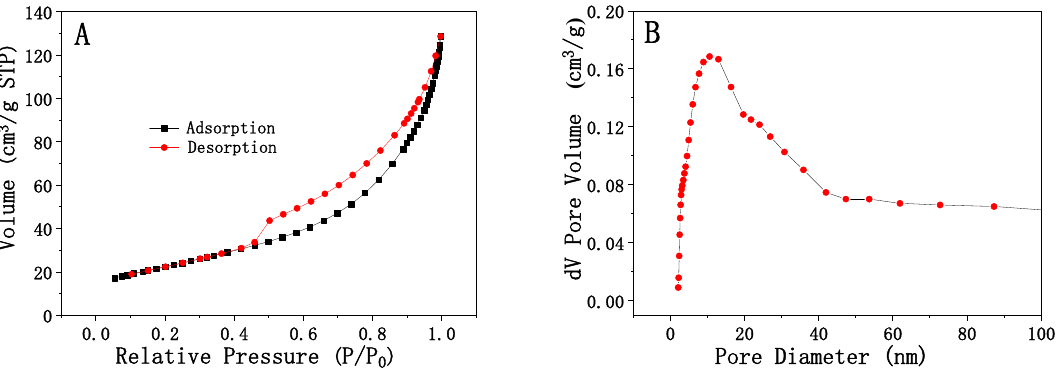
Figure 4. ( A ) N 2 sorption isotherms and ( B ) pore size distributions of NiCo 2 O 4 /MWCNTs.